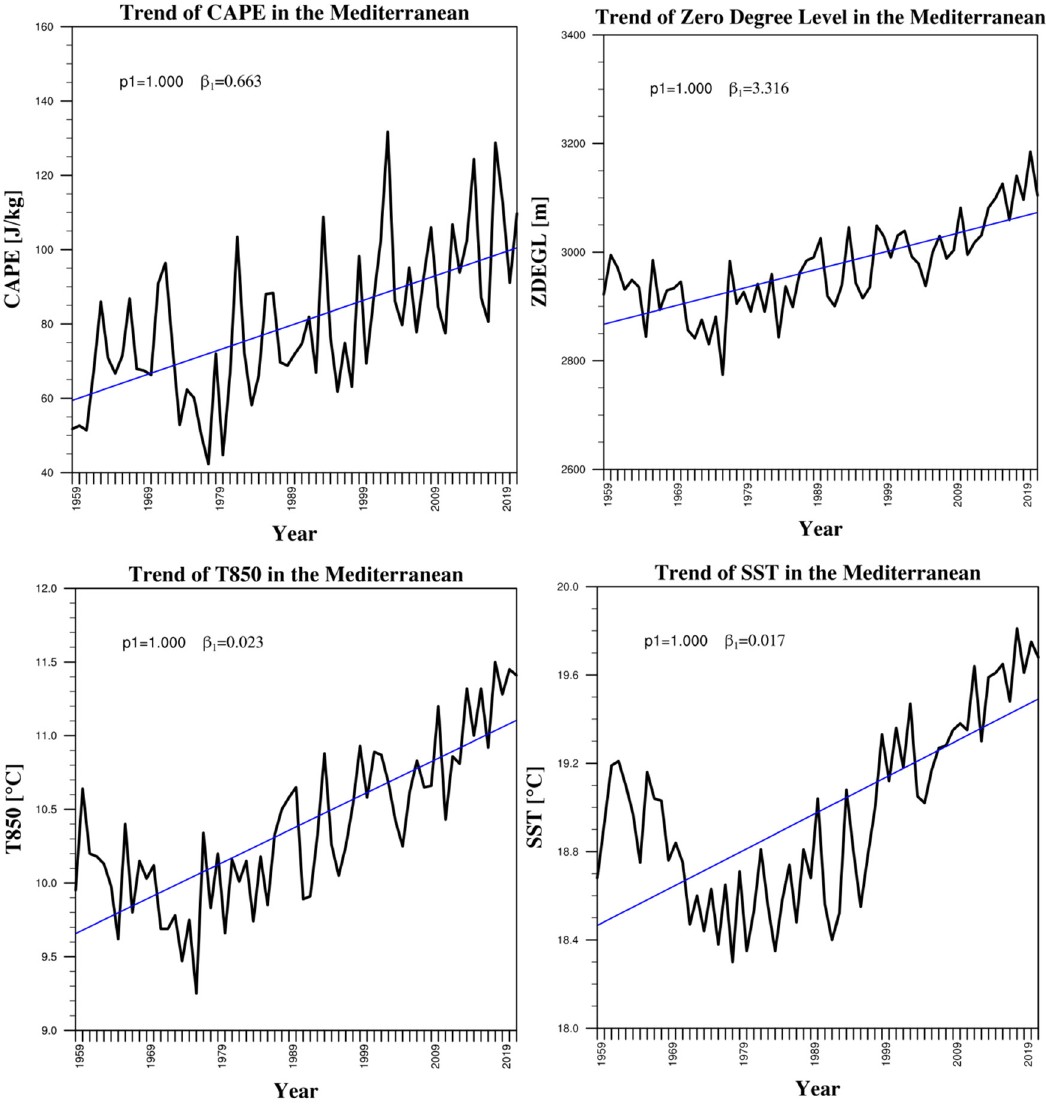
Figure 15. Annual trends for the Convective Available Potential Energy (CAPE), the Zero Degree Level (ZDEGL), the temperature at 850 hPa (T850) and the Sea Surface Temperature (SST) calculated for the entire Mediterranean Sea. Blue line displays the tendency of series.